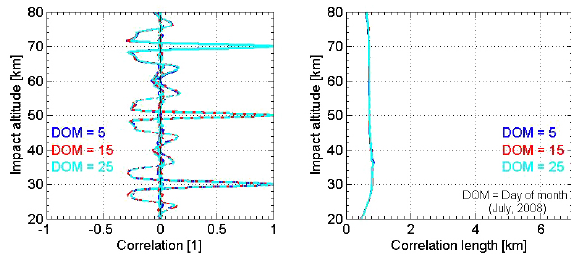
Figure 5. Global-mean error correlation functions from the obser- vation error covariance matrix (left), for the 5, 15, and 25 July 2008 at three representative impact altitude levels (30, 50, and 70km), and estimated correlation lengths of the correlation functions (right) at all impact altitude levels from 20 to 80km for the same 3 days. For ease of intercomparison the layout is the same as in Fig.